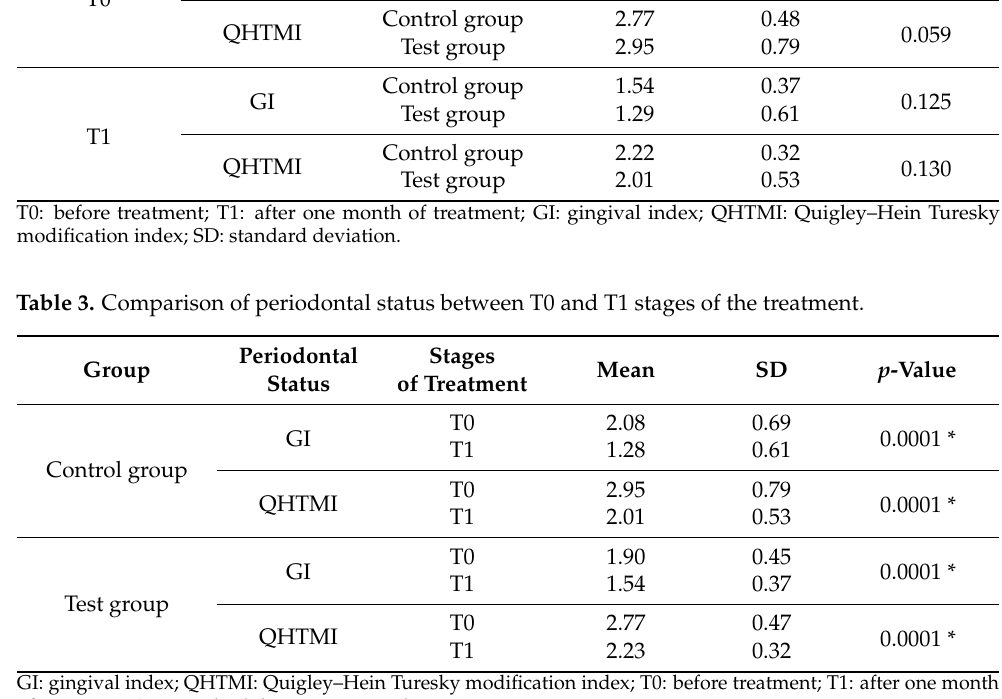
0.082 0.059 0.125 0.130